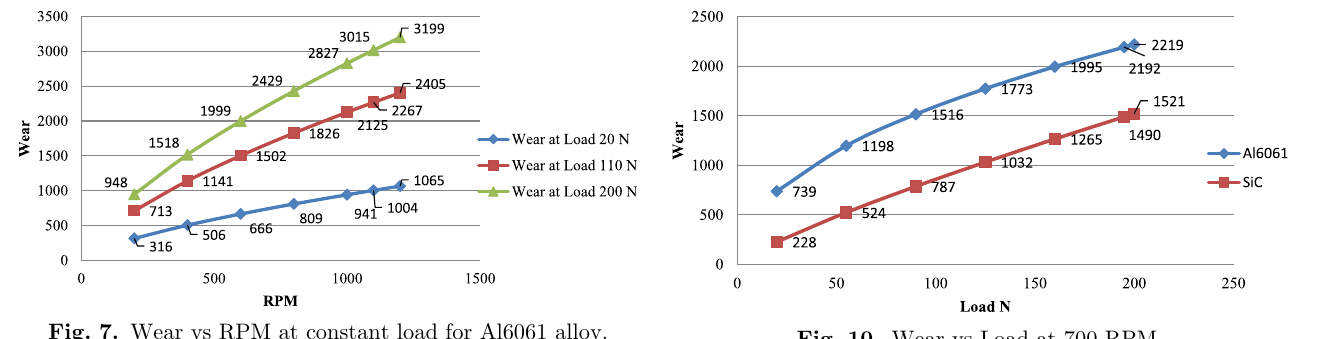
Fig. 7. Wear vs RPM at constant load for Al6061 alloy.